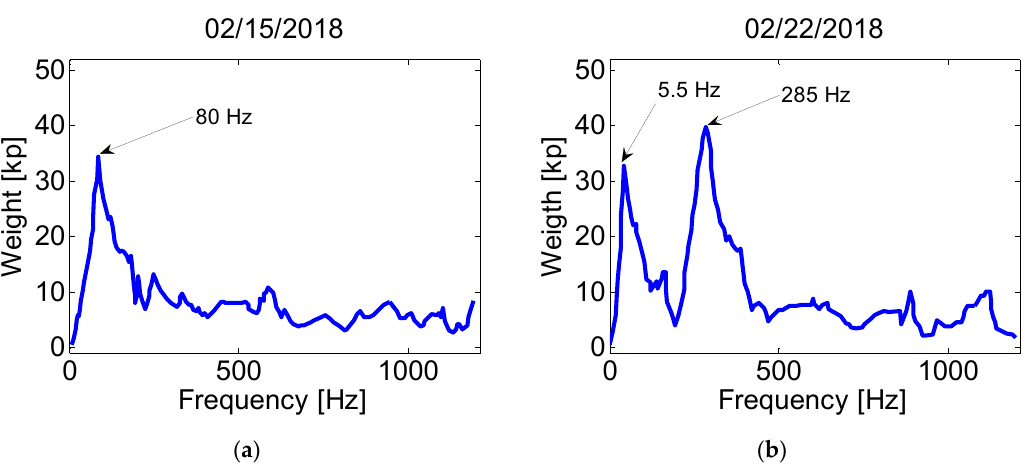
Figure 7. Frequency spectra captured in the power train and recorded by the Argolabe S.L. Company. Weight versus frequency. ( a ) Signal with one resonance, when ω g ≈ 500 rpm; ( b ) Signal with two resonances, when ω g ≈ 645 rpm.